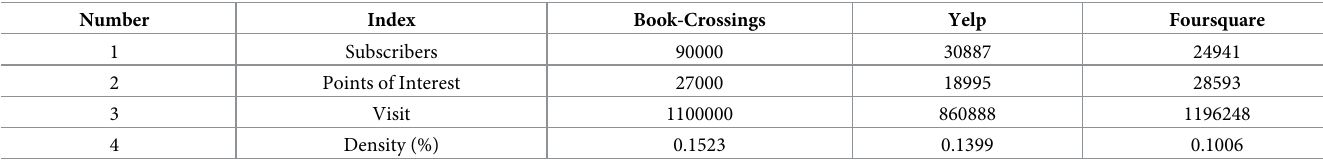
Table 1. Basic information of experimental